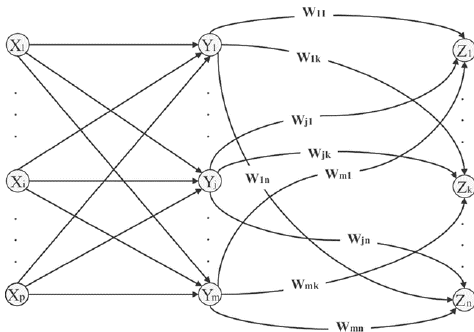
Figure 5. Backpropagation of MLP architecture with one hidden layer.